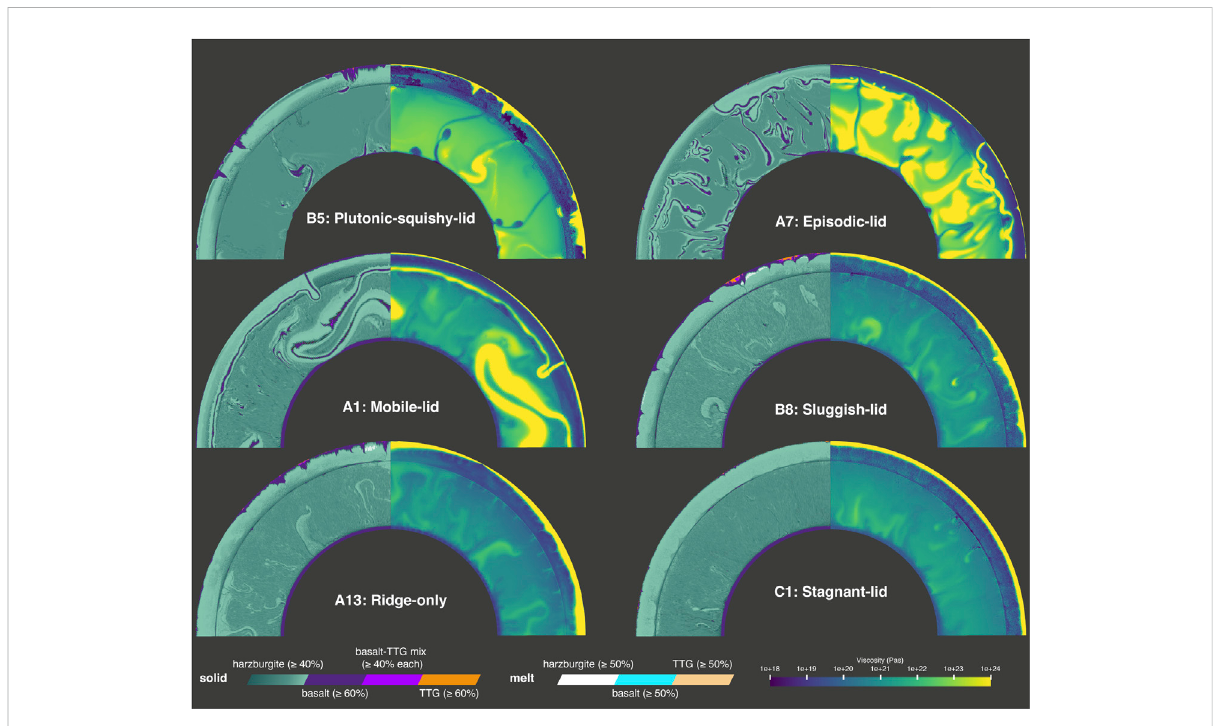
FIGURE 5 Snapshots of different cases showing composition and viscosity fi elds to illustrate the different tectonic regimes. Note that, even though different η max values were used in these cases, only one colorscale for viscosity fi eld is